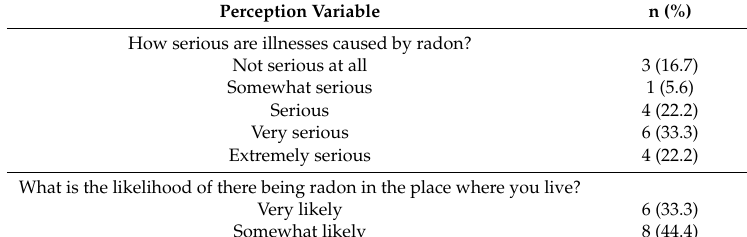
Somewhat likely